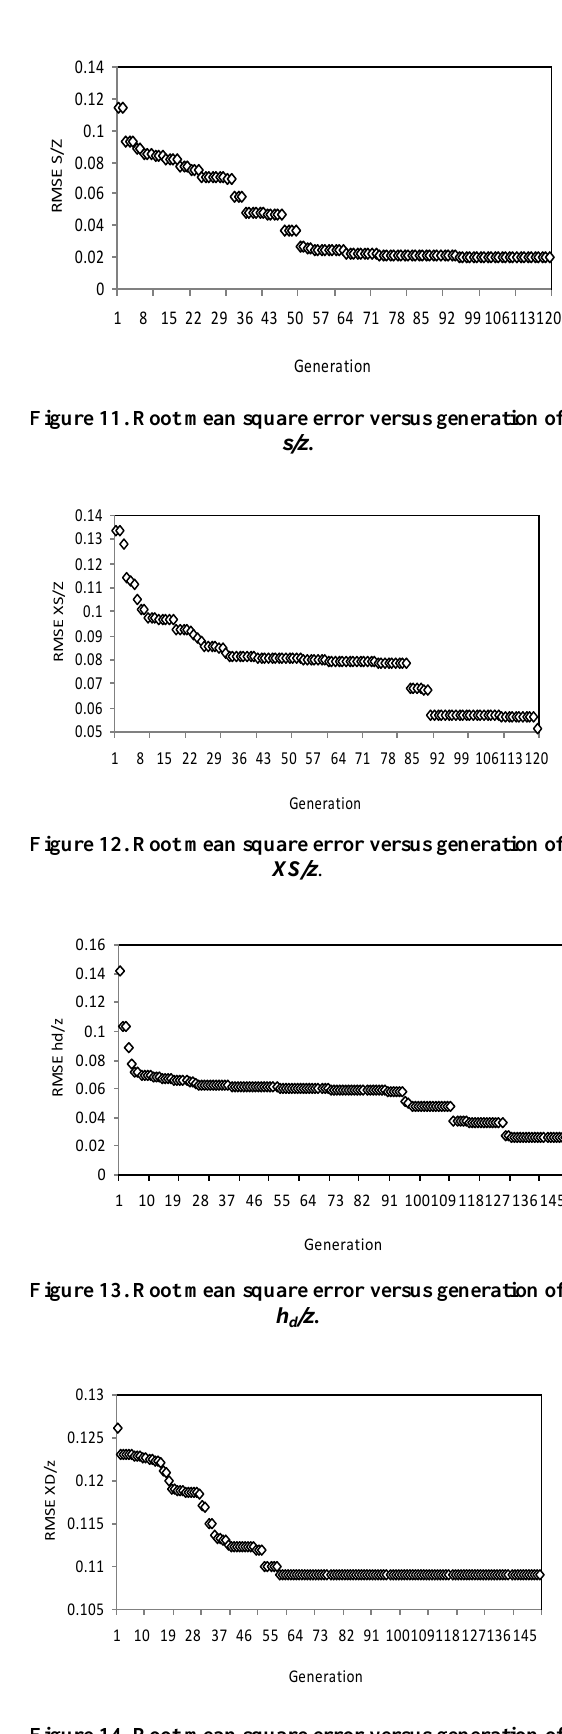
Figure. 10. Comparison between observed and predicted GP to estimate XD/z .